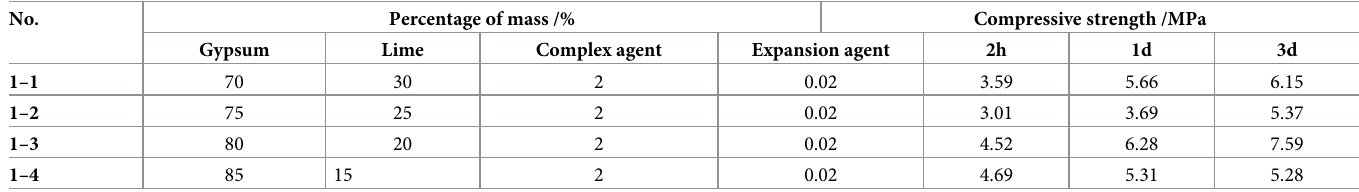
Table 1. Different proportions of gypsum and lime and the effect of these variations on the compressive strength of the sealing material.